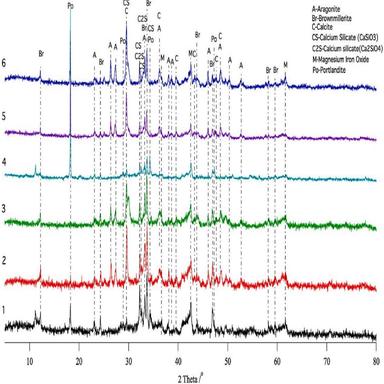
XRD patterns of the SS pastes before and after carbonation curing (1: paste S, before carbonation curing; 2: paste S, carbonation curing for 1 d; 3: paste S, carbonation curing for 14 d; 4: paste SC, before carbonation curing; 5: paste SC, carbonation curing for 1 d; 6: paste SC, carbonation curing for 14 d; paste S: 100 % SS; paste SC: 80 % SS + 20 % PC).